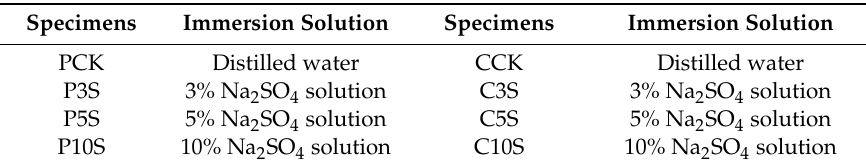
Table 3. The details of specimens and